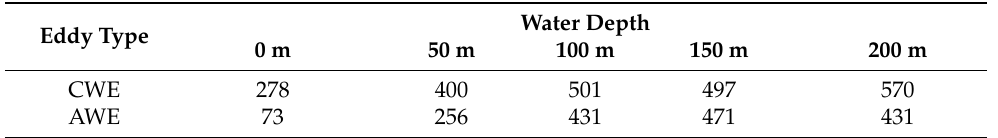
Table 1. Numbers of coherent CWEs and AWEs detected from water depths of 0 m to 200 m based on the